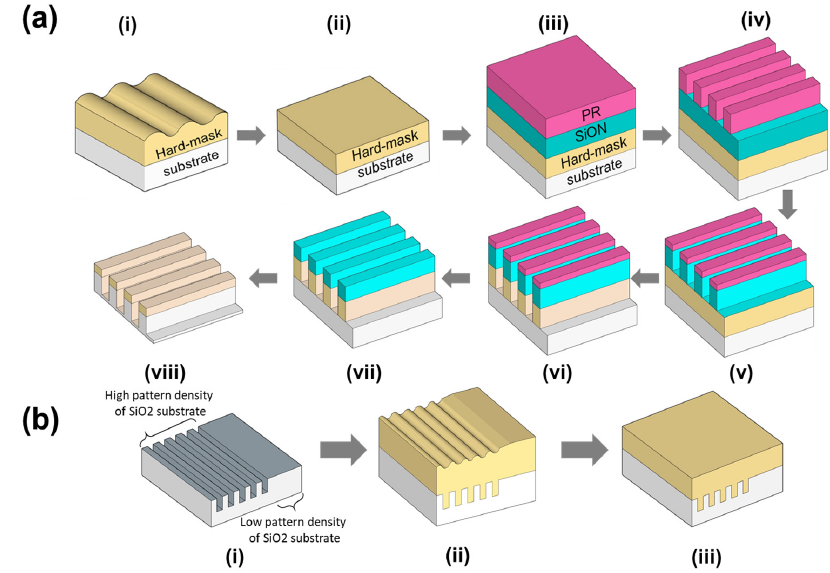
Figure 1. ( a ) Fabrication process flow of the lithography and etching using the SOC film hard-mask followed by CMP. ( b ) SOC film surface CMP.